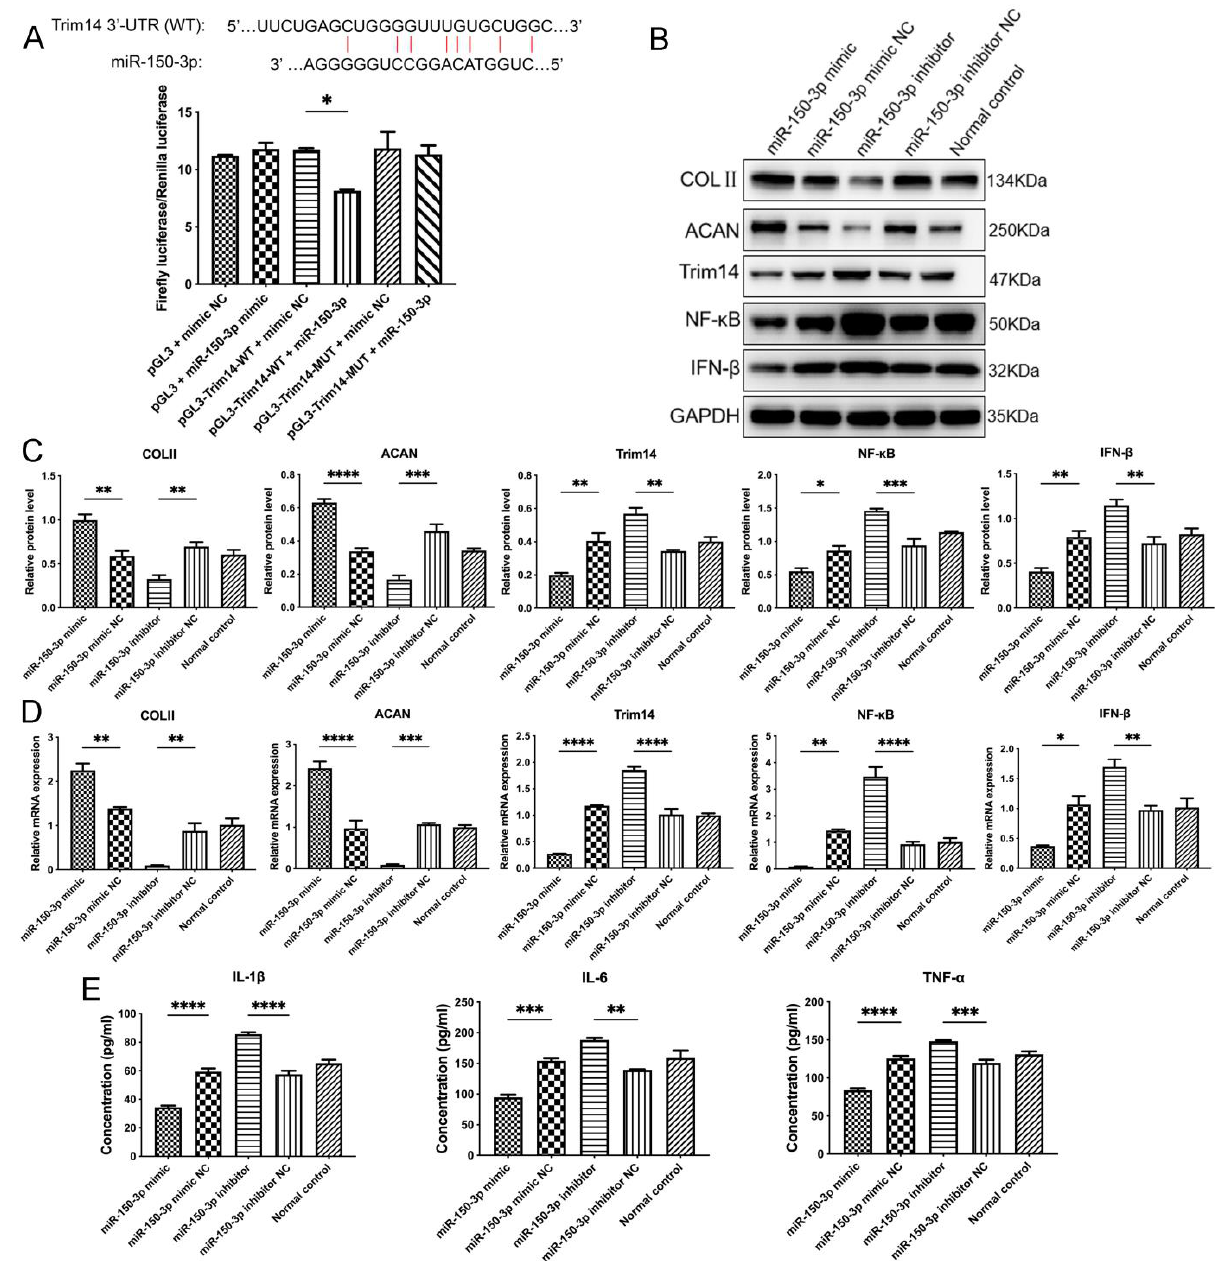
Figure 9. Validation of the miR-150-3p target and the regulatory effect of miR-150-3p on the innate immune signaling and joint homeostasis. ( A ) A miR-150-3p binding site on Trim14 and validation of miR-150-3p targeting Trim14 through the dual luciferase assay. ( B , C ) COLII, ACAN, Trim14, NF- κ B, and IFN- β protein levels were analyzed using WB. ( D ) qPCR analysis of the Trim14, NF- κ B, IFN- β , COLII, and ACAN mRNA levels in chondrocytes after miR-150-3p interference. ( E ) ELISA- based quantitation of the pro-inflammatory cytokines IL-1 β , IL-6, and TNF- α in the chondrocyte culture medium. The data are expressed as mean ± SEM from three independent